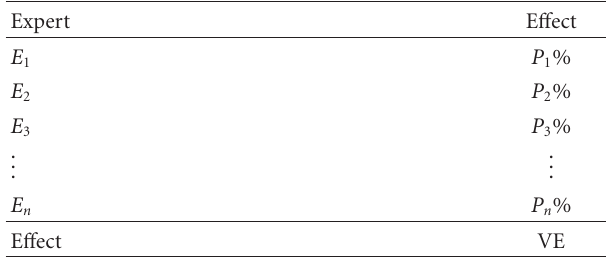
Table 10: Some risks in an organization.